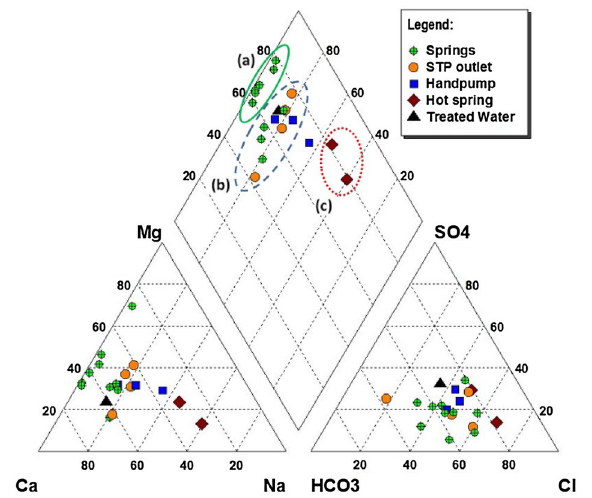
Fig. 5 Piper’s trilinear plot water samples depicting the various hydrochemical facies